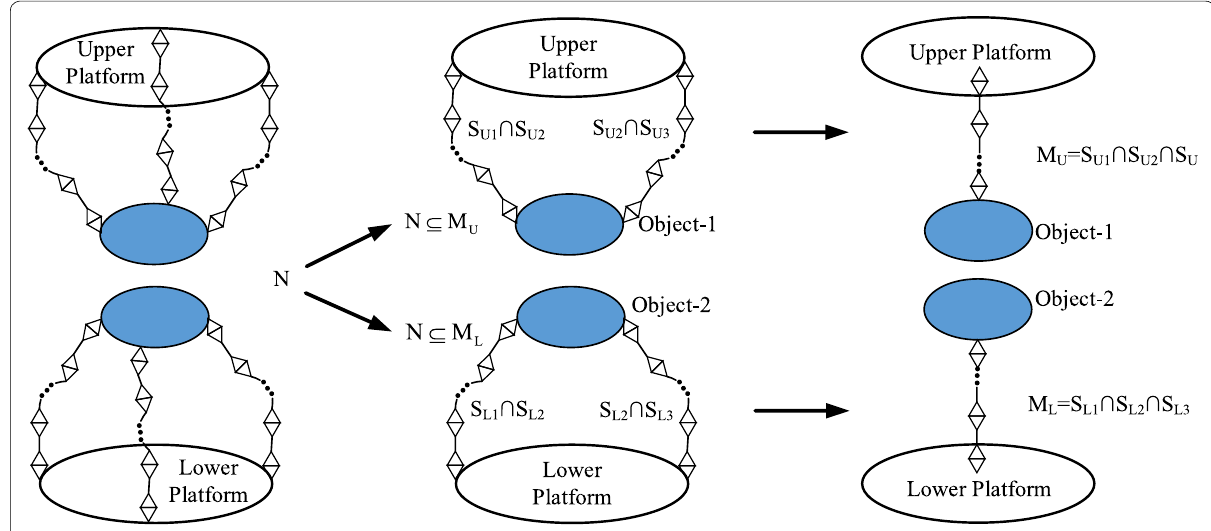
Figure 13 Schematic of platform decomposition with three